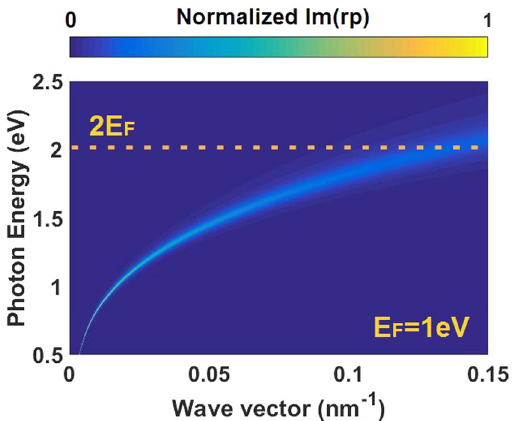
Figure 1. Plasmon dispersion of monolayer graphene when the graphene is doped (For clarify, here we use highly doped graphene with E F = 1 eV.), as illustrated by the photon-energy and parallel-wave-vector dependence of the imaginary part of reflection coefficient for p-polarization. Interband absorption produces strong plasmon quenching when the photon energy exceeds 2 E F (i.e., above the yellow dash line).